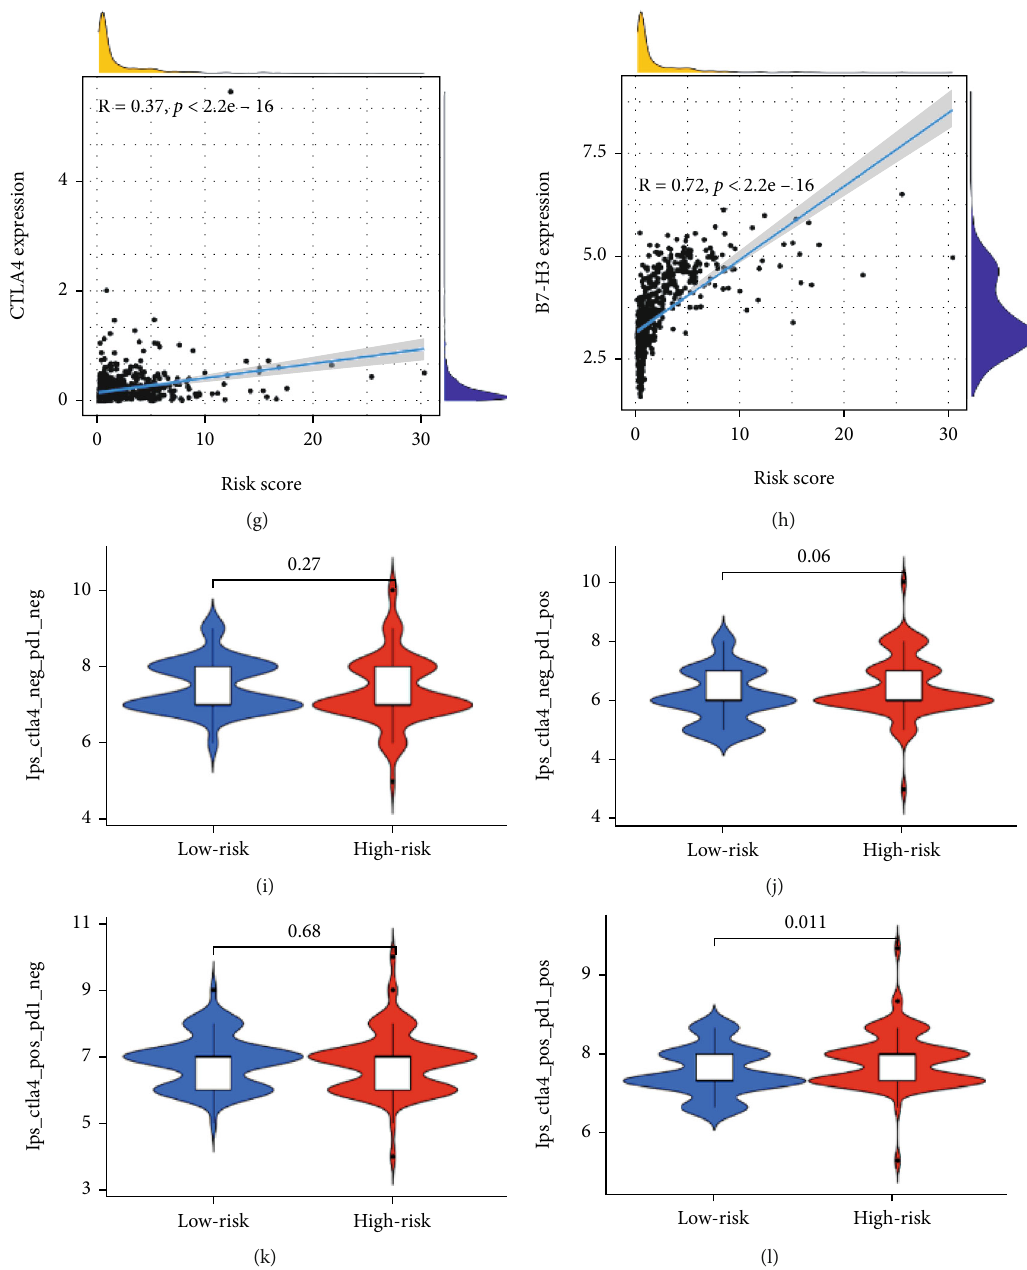
Figure 9: The relationship between the IRRG signature and the levels of ICI expressions. The comparison of the levels of expression of (a) PD-1, (b) PD-L1, (c) CTLA4, and (d) B7-H3 between the low- and high-risk groups. The Pearson correlation coe ffi cients between risk scores and (e) PD-1, (f) PD-L1, (g) CTLA4, and (h) B7-H3. Comparison of the immunophenoscore (IPS) between the low- and high-risk groups strati fi ed as (i) CTLA4 negative /PDL1 negative , (j) CTLA4 negative /PDL1 positive , (k) CTLA4 positive /PDL1 negative , and (l) CTLA4 positive /PDL1 positive